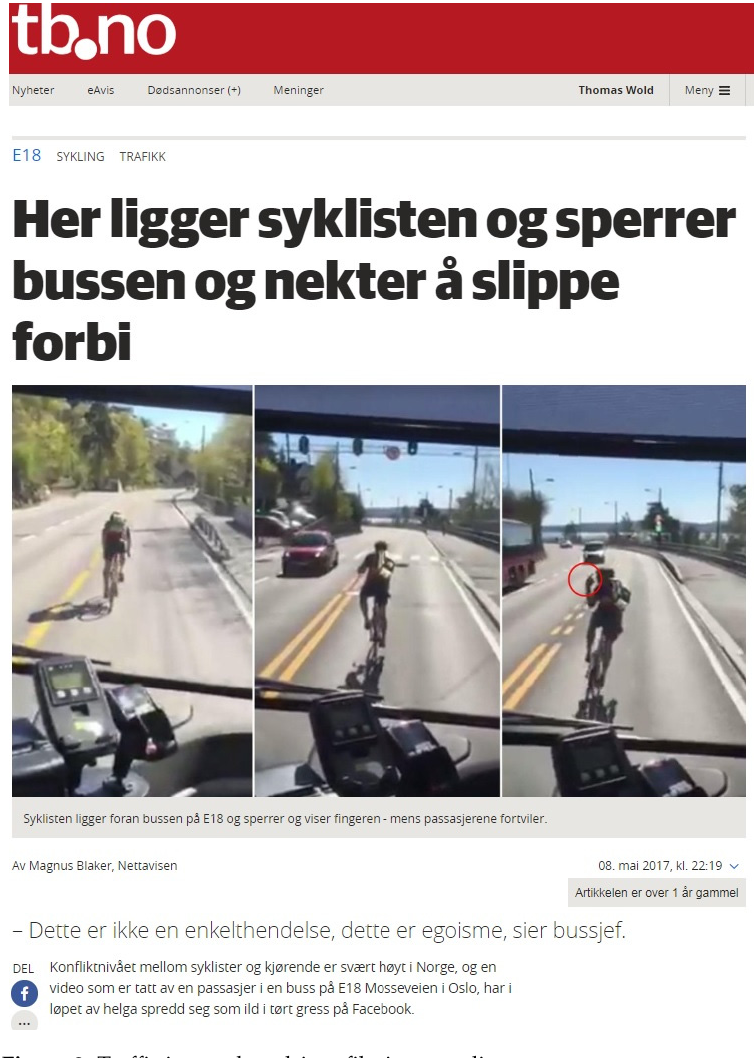
Figure 2. Traffic issues: bus driver filming a cyclist.